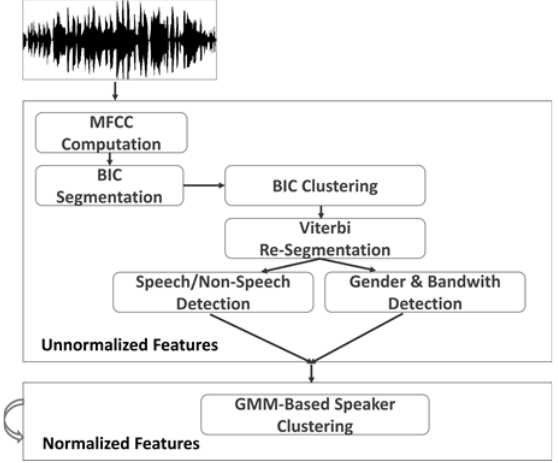
Figure 3 . Typical workflow for speaker diarization and segmentation, adapted from LIUM Speaker Diarization Wiki Page (http://www-lium.univ-lemans.fr/diariza-